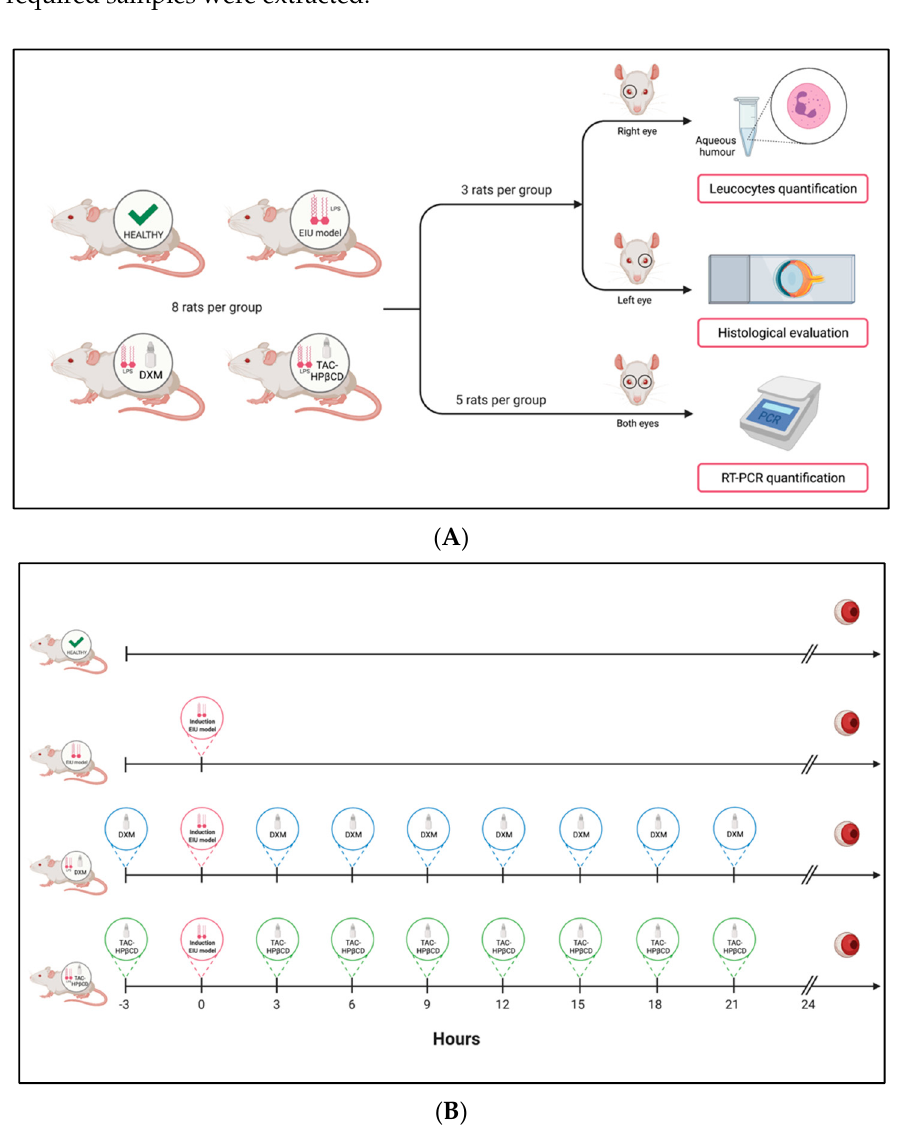
Figure 1. ( A ) Study groups scheme and distribution of eyes for their posterior analysis. ( B ) Study timeline: Induction EIU model, treatments, euthanasia and eyes removal. Created with BioRender.com.